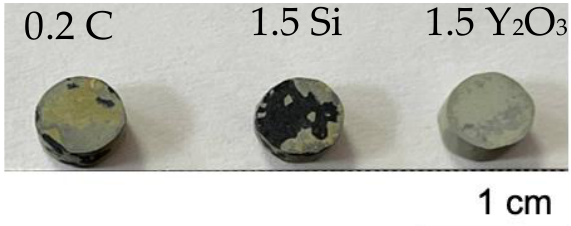
Figure 6. A cross-sectional oxidized layer image of the alloys 0.2C ( a ), 1.5Si ( b ), and 1.5Y 2 O 3 ( c ) after isothermal annealing at 800 °C.